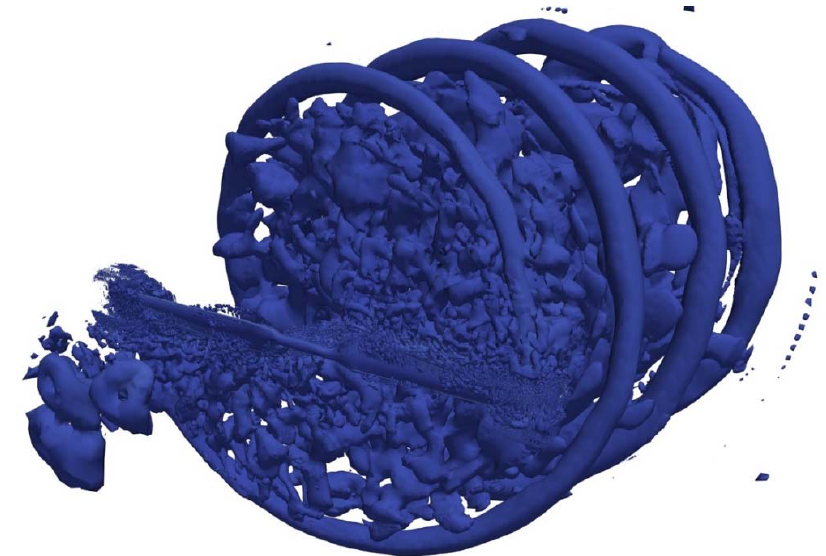
Figure 18. Vorticity contours when wind speed = 10 m/s (VLES).